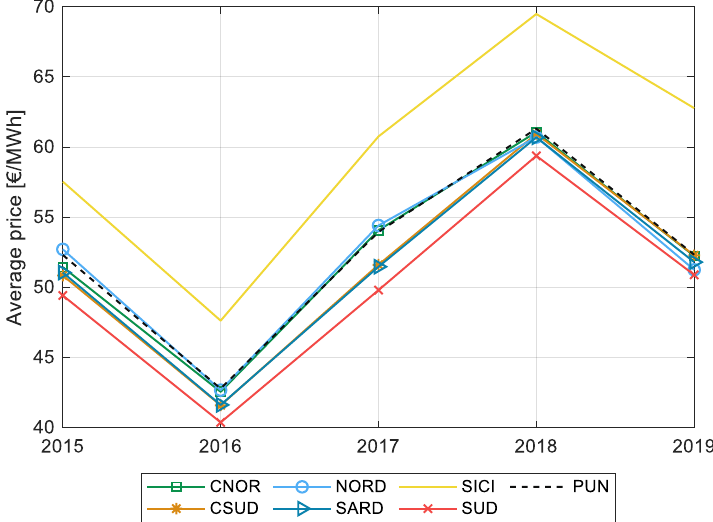
Figure 2. Average zonal and national electricity price trend for the period 2015–2019 [4].